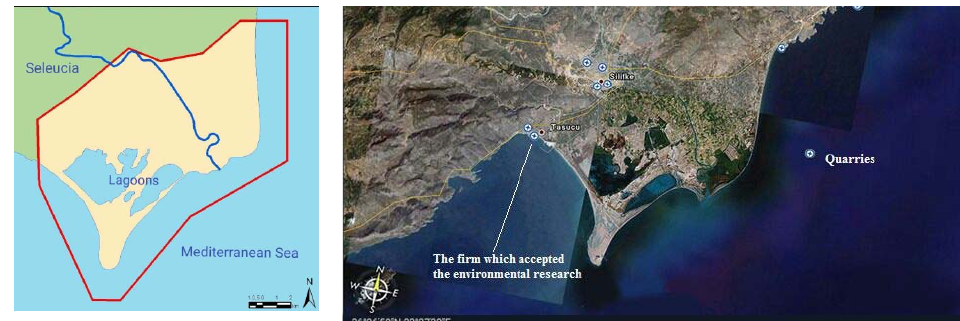
Fig. 1: A) Illustration of the study area